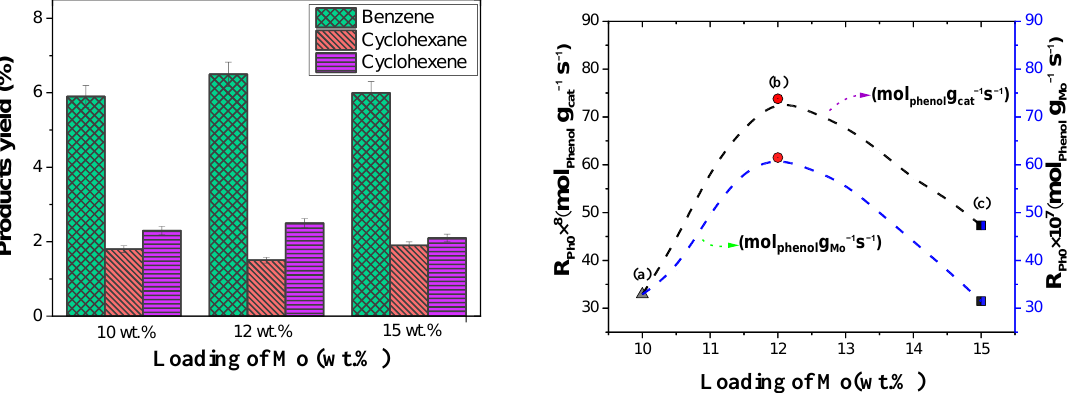
Figure 5. ( Left ) Products yield of the HDO of phenol over CoMoS/AT2 catalysts at 10% of conversion. ( Right ) Comparison of the initial reaction rates of CoMoS/AT2 with different Mo loadings at 320 °C and 5.5 MPa.